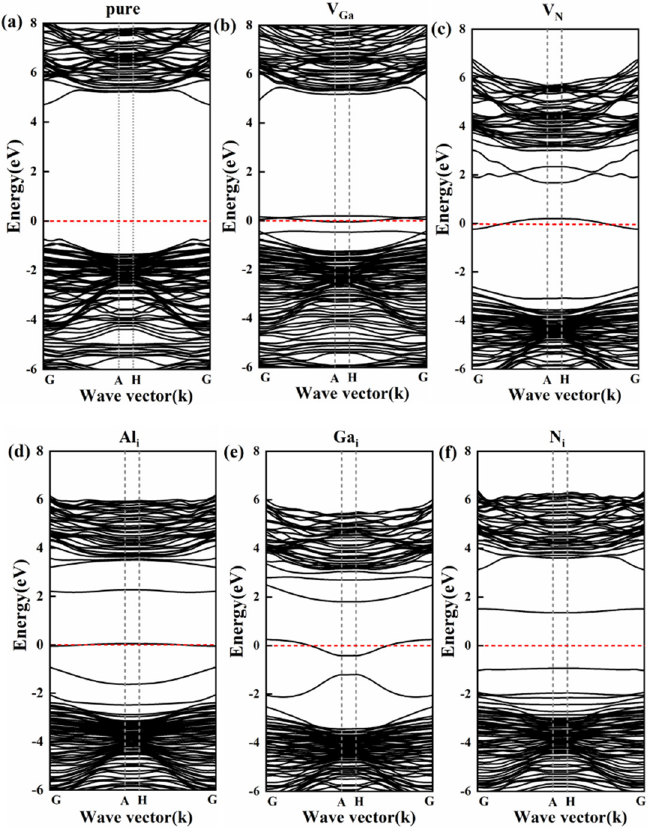
Figure 3. Band structures of different models: ( a ) pure Al 0 . 5 Ga 0 . 5 N nanowires, ( b ) V Ga , ( c ) V N , ( d )Al i , ( e ) Ga i , ( f ) N i .